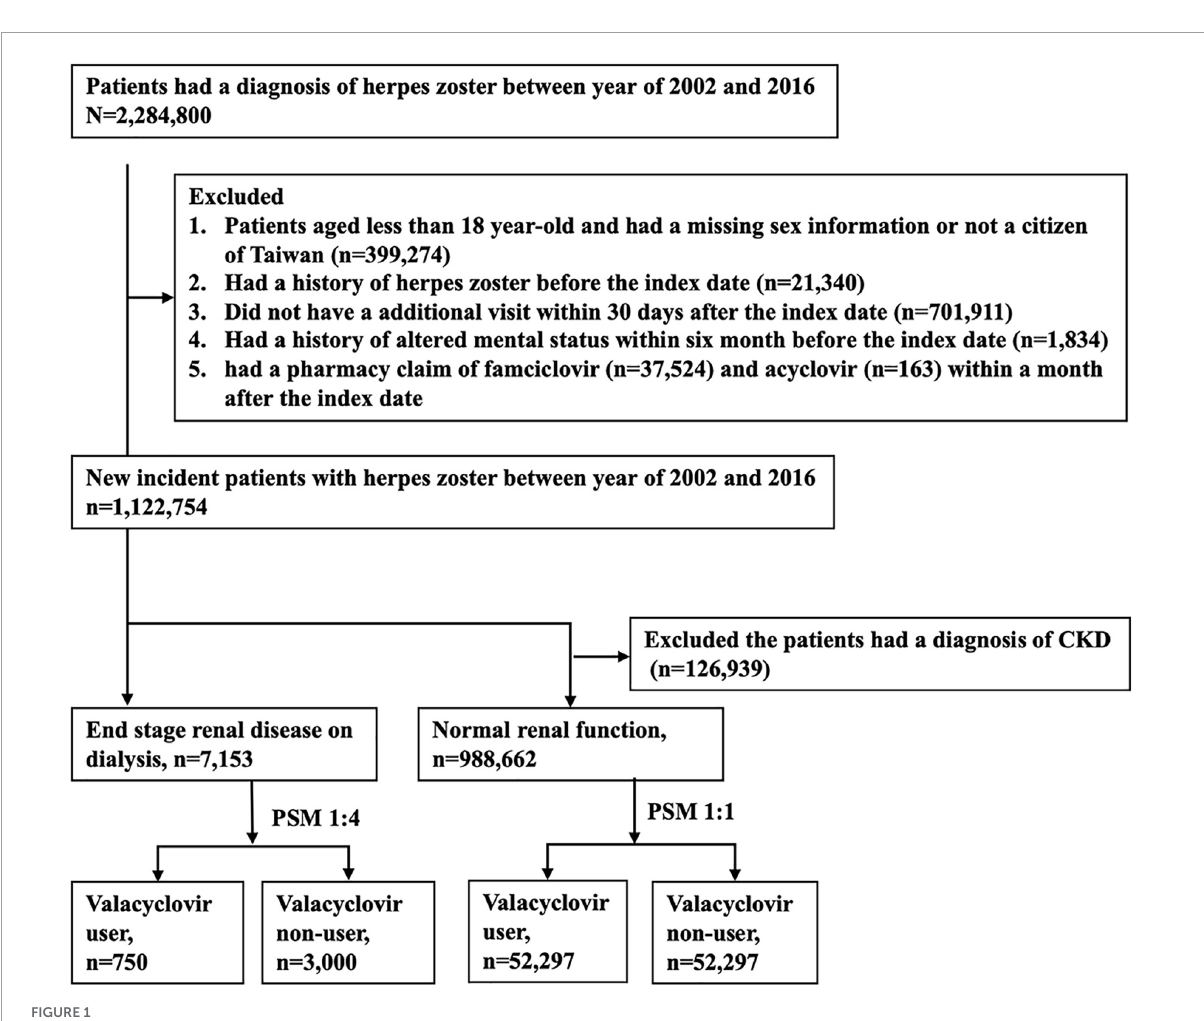
FIGURE1 Patient selection process. PSM, propensity score